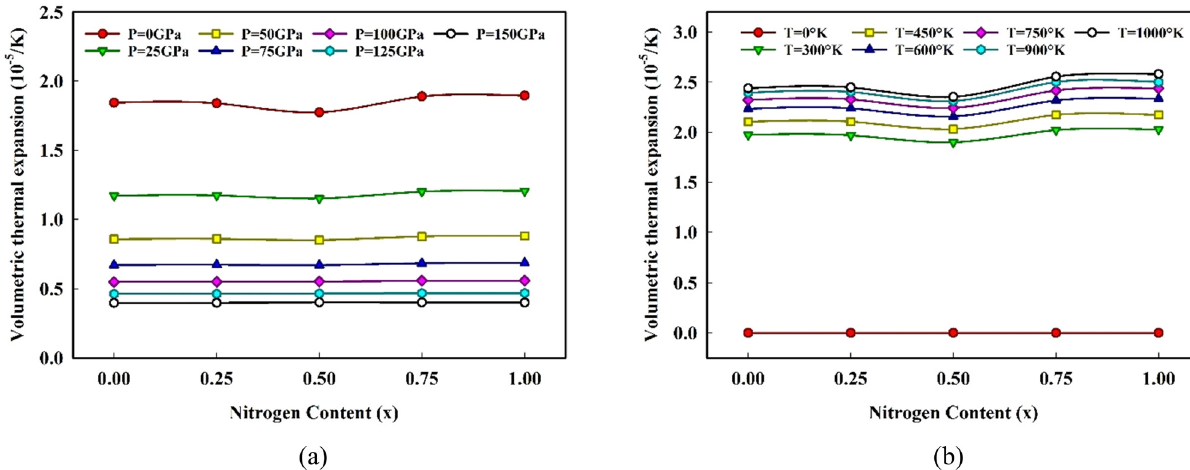
Figure 6: Volumetric expansion coe ffi cient of ZrC ( 1 − x ) N x as a function of nitrogen content ( x ) for ( a ) di ff erent pressures at 300 K and ( b ) di ff erent temperatures at zero pressure.